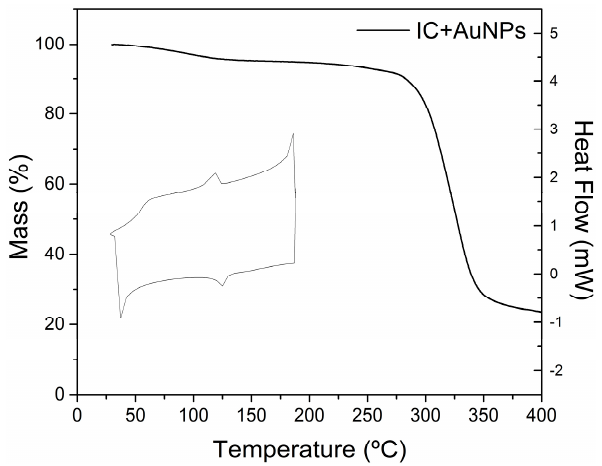
Figure 4. Thermogram (DSC/TGA) of the α -CD/OA IC crystals with fixed AuNPs. The temperature range was between 25 and 400 °C for TGA, and between 25 and 200 °C for DSC, with a heating rate of 10 °C·min − 1 .